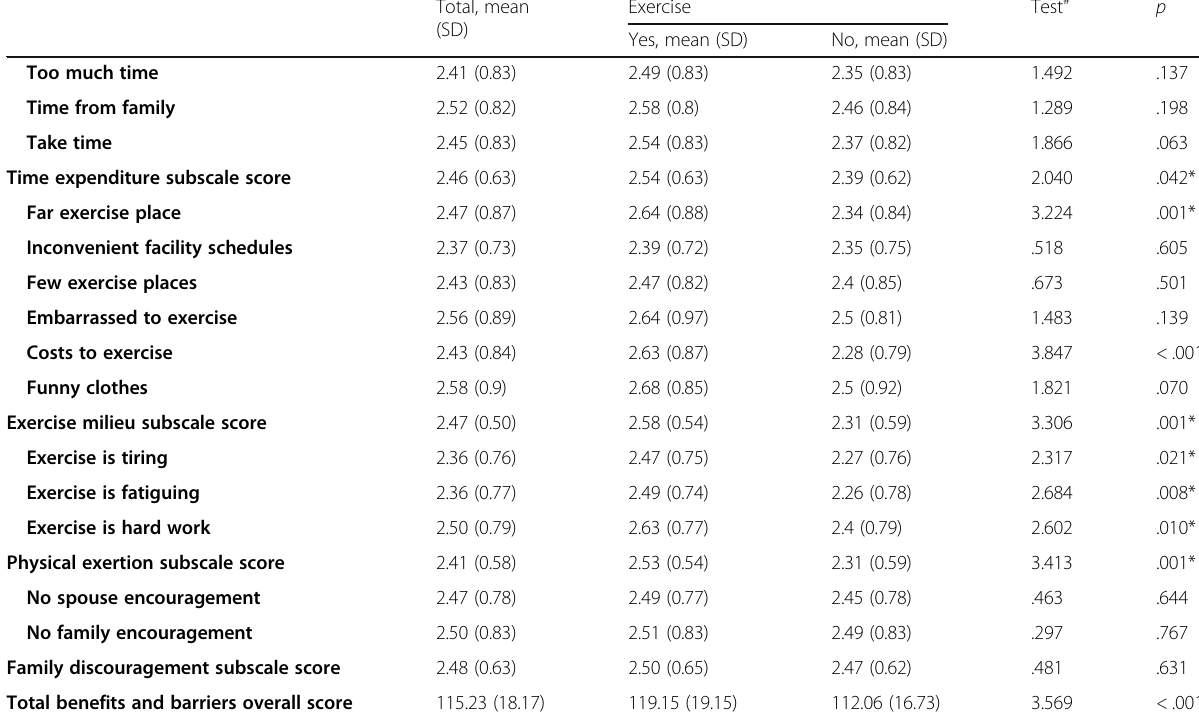
Table 4 Exercise barriers statements and subscales scores in terms of exercise